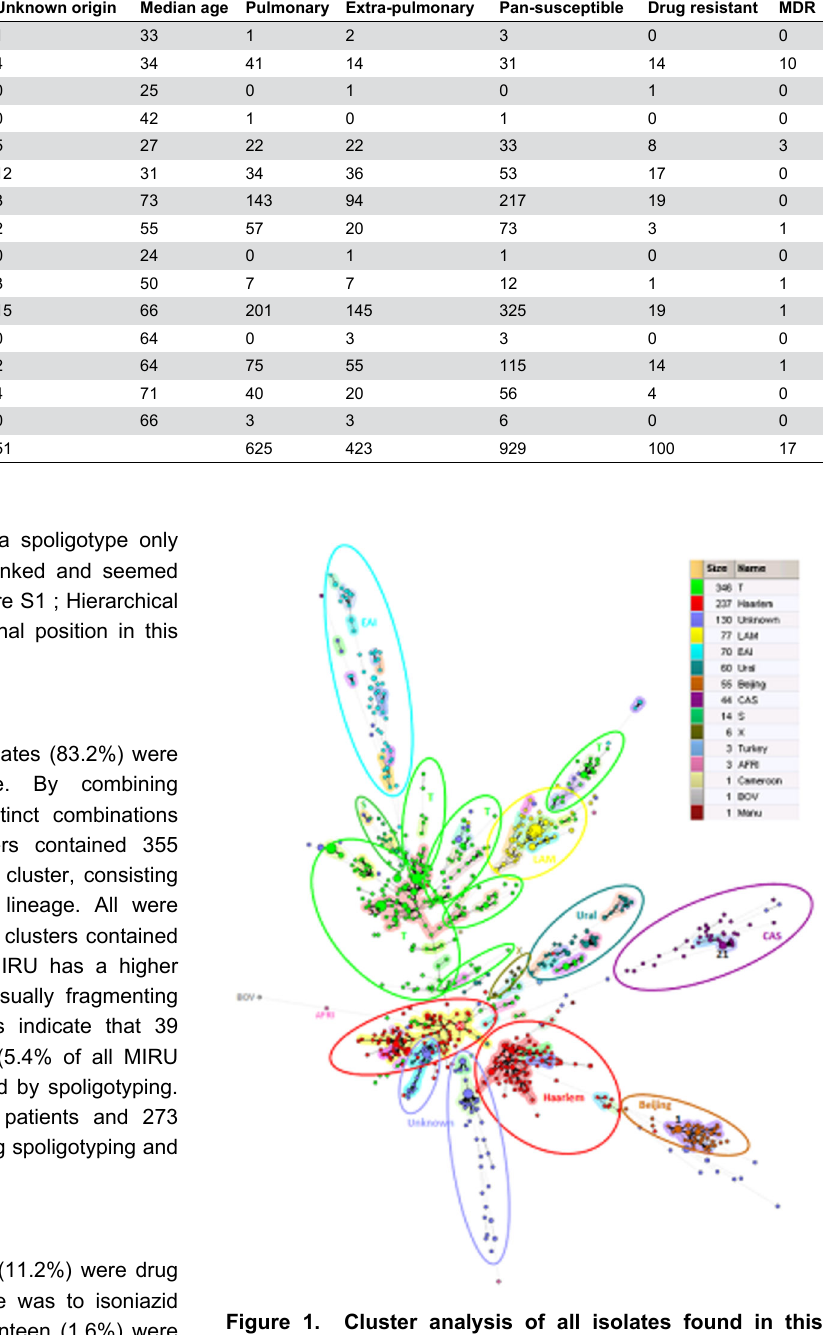
Table 1. An overview of the lineages found in Finland, 2008-2011.